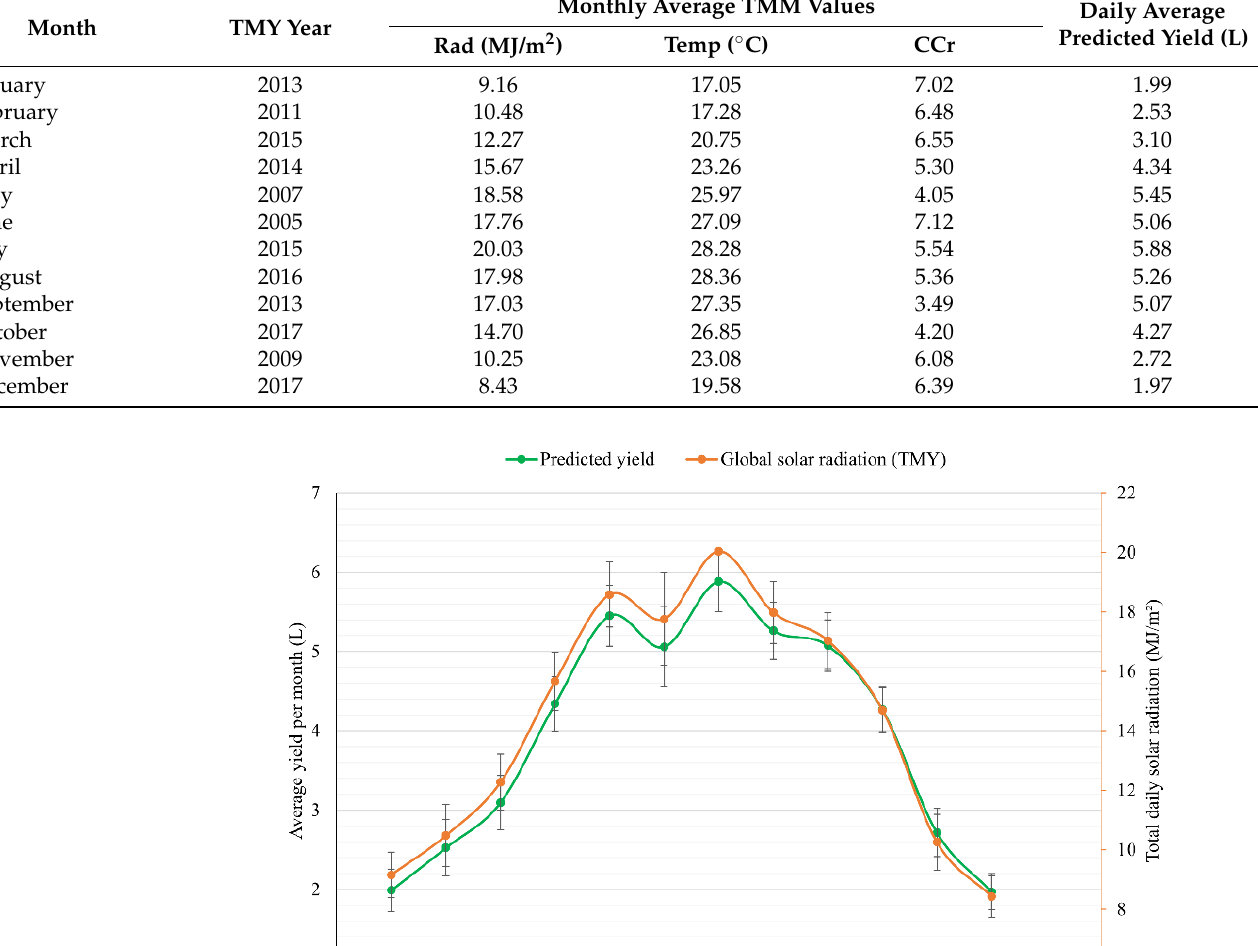
Table 9. Monthly average values of the three predictor variables and predicted yield for each TMM.